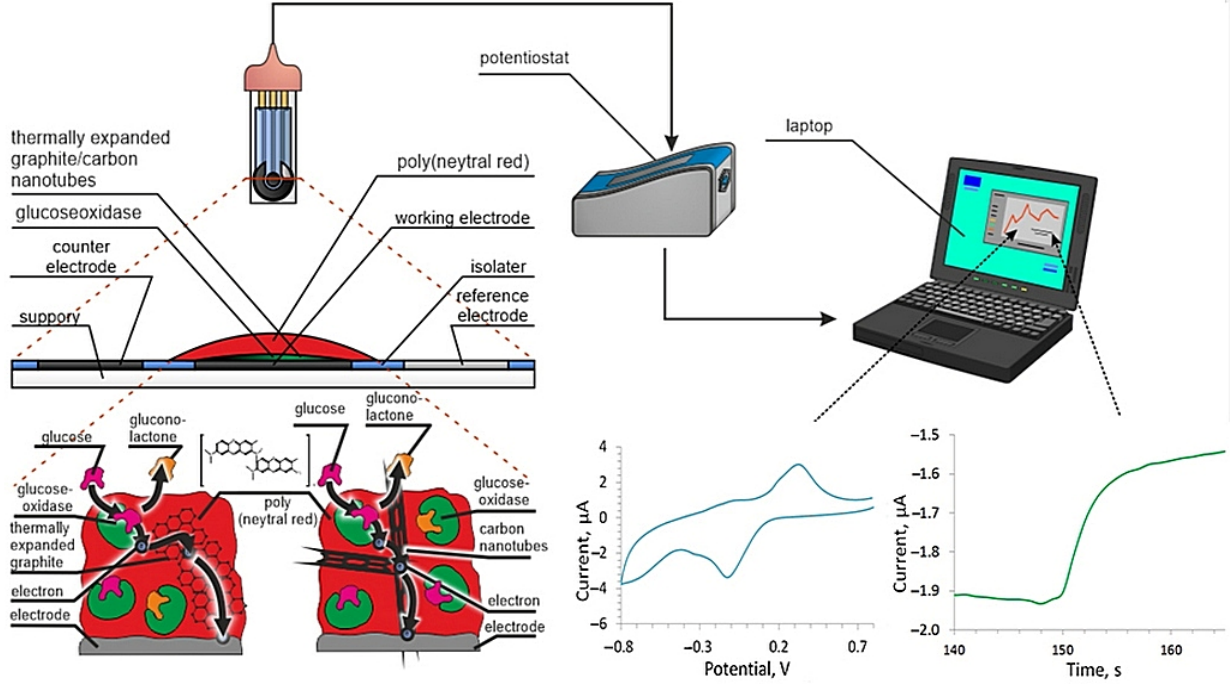
Figure 2. Scheme of the used three-electrode graphite printed electrode and biosensor setup for glucose determination and structure of electrodes modified with nanocomposite materials based on a conductive polymer poly (neutral red).